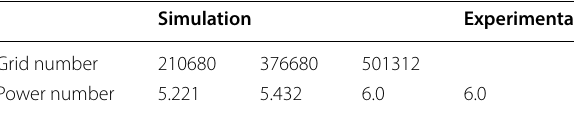
Table 2 Comparison of power number between simulation with different grid number and experimental of baffled tank (at Re 10 5 =